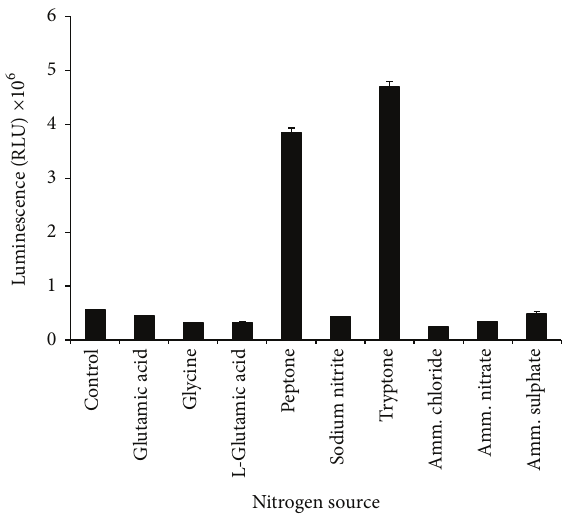
Figure 4: Effects of different nitrogen sources on bioluminescence production by Photobacterium sp. strain MIE. The cultures were grown in luminescence media containing 10g/L nitrogen sources and incubated in an orbital shaker (100rpm) for 12 hours at room temperature. Data is mean ± standard error of the mean ( 𝑛 = 3 ). The cultures were grown without nitrogen source as control.